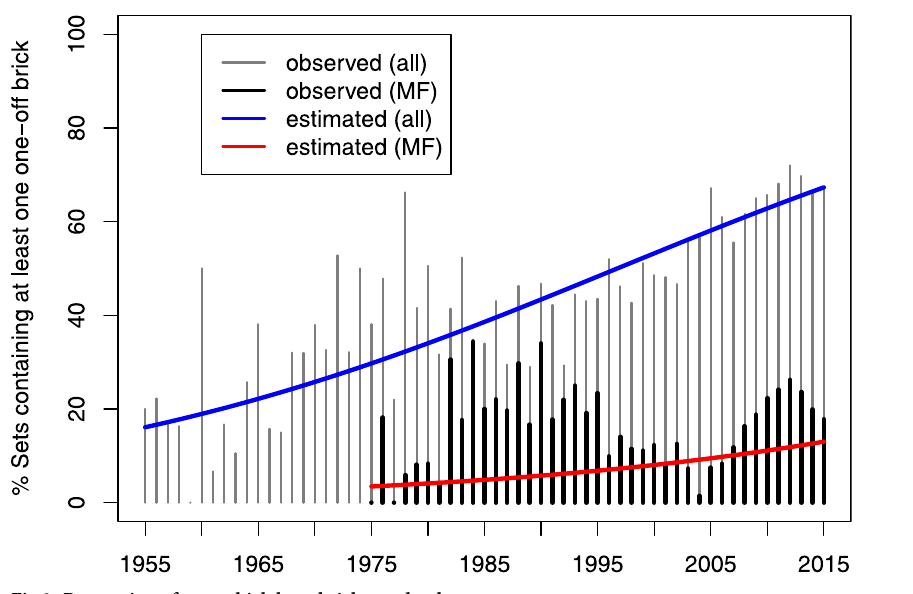
Fig 3. Proportion of sets, which have bricks used only once.